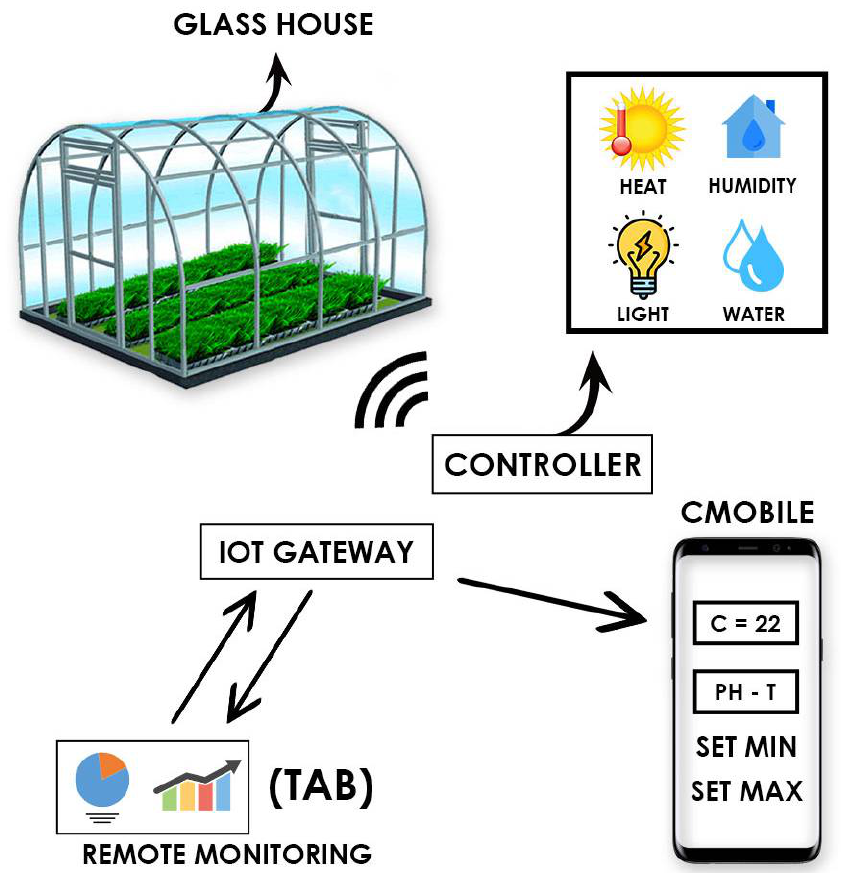
Figure 1. Design and Implementation of Integrated Control System—Sensors for “Smart” Green- houses based on the Internet of Things (IoT) Technologies (Picture Credit: Kainat Fatima) .